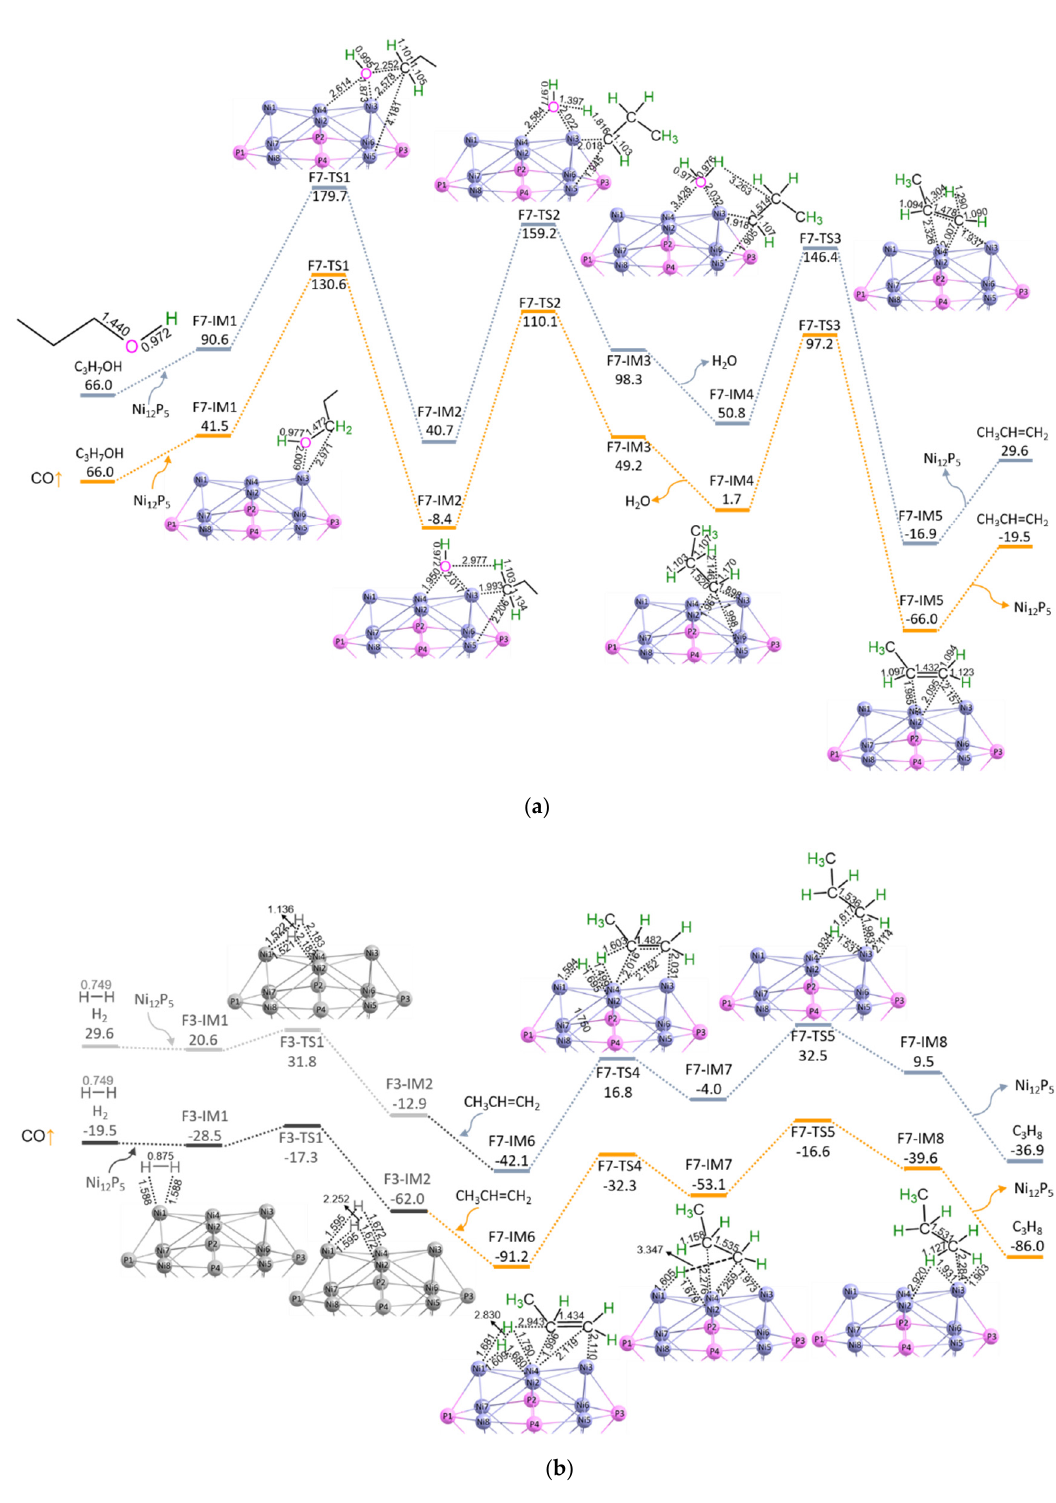
Figure 7. The potential energy curves with the relative Gibbs free energy ( G r , kJ mol − 1 ) and the geometric structures with bond lengths (Å) for reaction stages S7a ( a ) and S7b ( b ) over Ni 12 P 5 cluster at GGA − PBE/DSPP, DNP level. For brevity, some hydrogen atoms are hidden. CO ↑ shows the CO pressure with 10 − 5 atm under experimental condition.